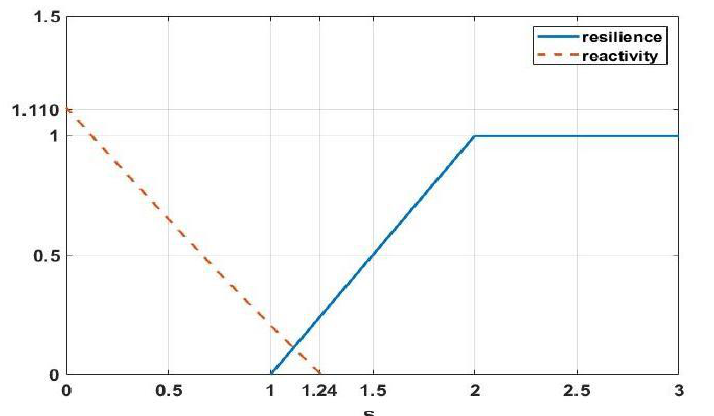
Figure 1. Resilience and reactivity in the mean square sense of system (7), ( c = 1). (2) Disturbance to prey ( σ 1 = 0.4, σ 1 = 0.8 and σ 2 = 0